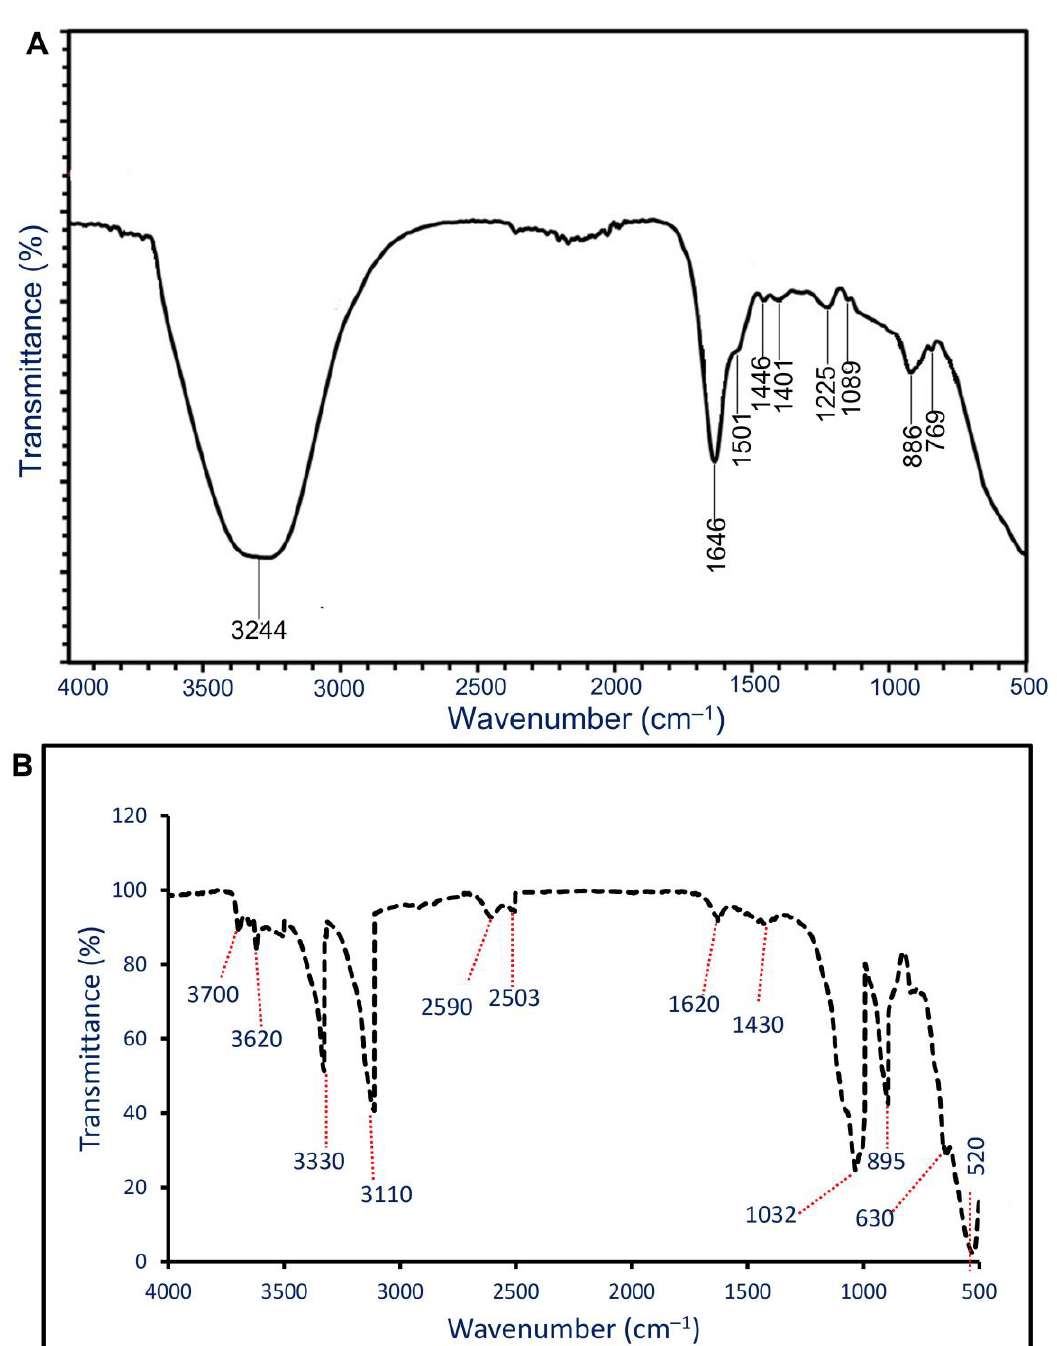
Figure 4. FT-IR of bacterial cell-free filtrate ( A ) and biosynthesized ZnO-NP ( B